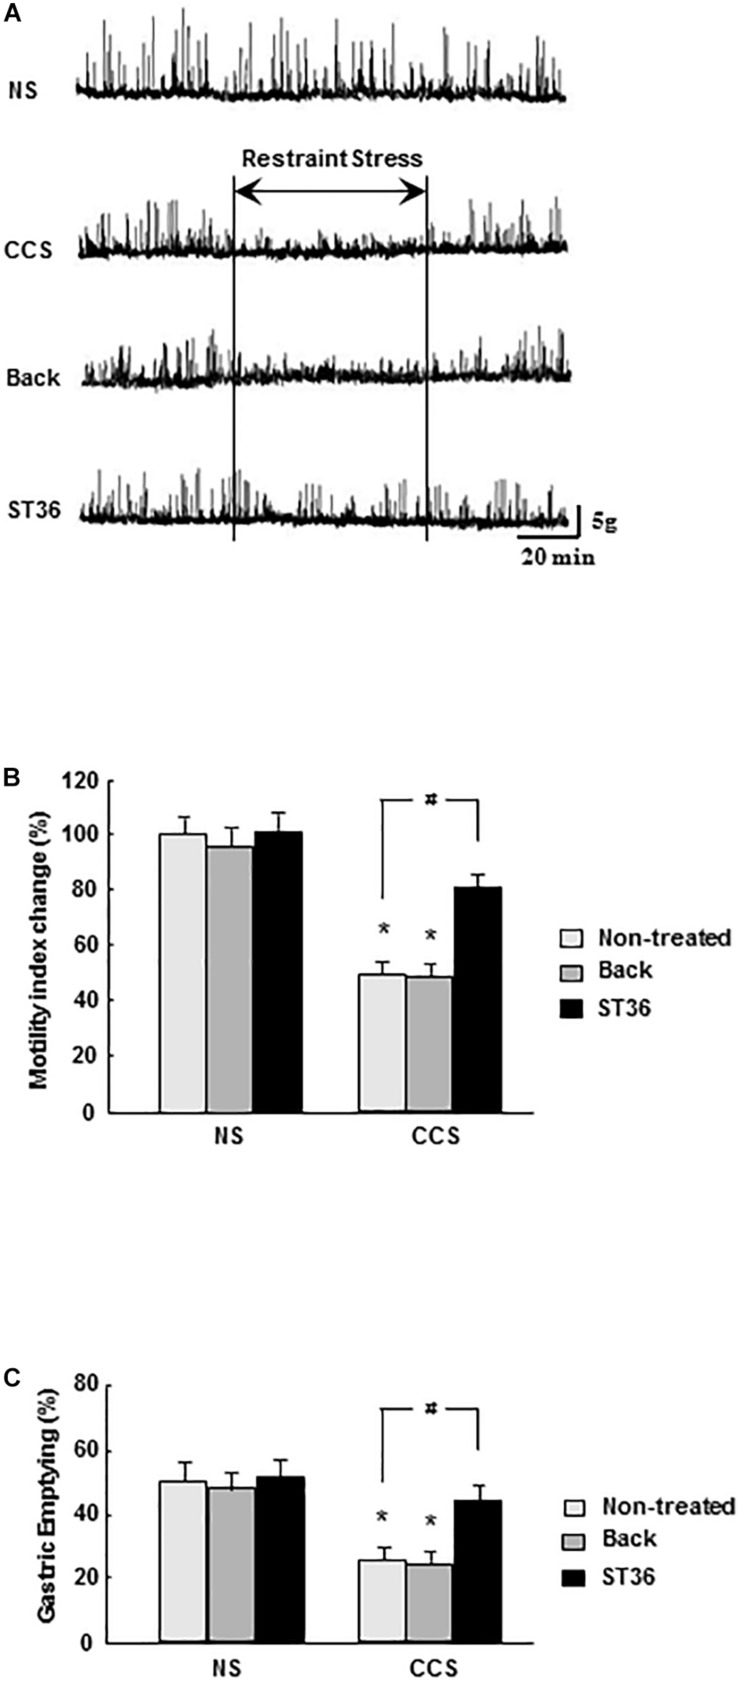
Effects of EA on gastric motility (A), gastric MI changes (B), and GE (C) in response to CCS. (A) The gastric phase III-like contractions in the non-stressed groups (NS). EA at back and EA at ST-36 had no effect on the gastric contractions (data not shown). CCS abolished gastric phase III-like contractions in the non-treated group. EA at back had no effects on the gastric contractions. However, the EA at ST-36 helped to partially restore the gastric phase III-like contractions. (B) In the NS group, EA at back and EA at ST-36 did not significantly alter the gastric MI change. In the CCS groups, gastric MI change was significantly decreased (non-treated). EA at back did not alter the gastric MI change significantly, however, the EA at ST-36 significantly increased the MI change. (C) In the NS groups, EA at back and EA at ST-36 did not significantly change the GE. In the CCS groups, the GE was significantly decreased. EA at back did not change the GE significantly, however, the EA at ST-36 significantly increased the GE (n = 6, *P < 0.05 compared with NS non-treated group, #P < 0.05 compared with CCS non-treated group).